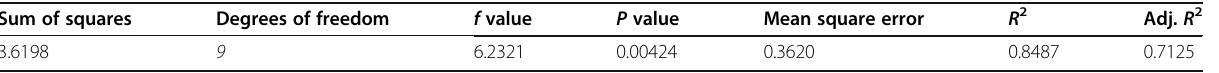
Table 5 ANOVA (analysis of variance) for response quadratic model for GABA production Sum of squares